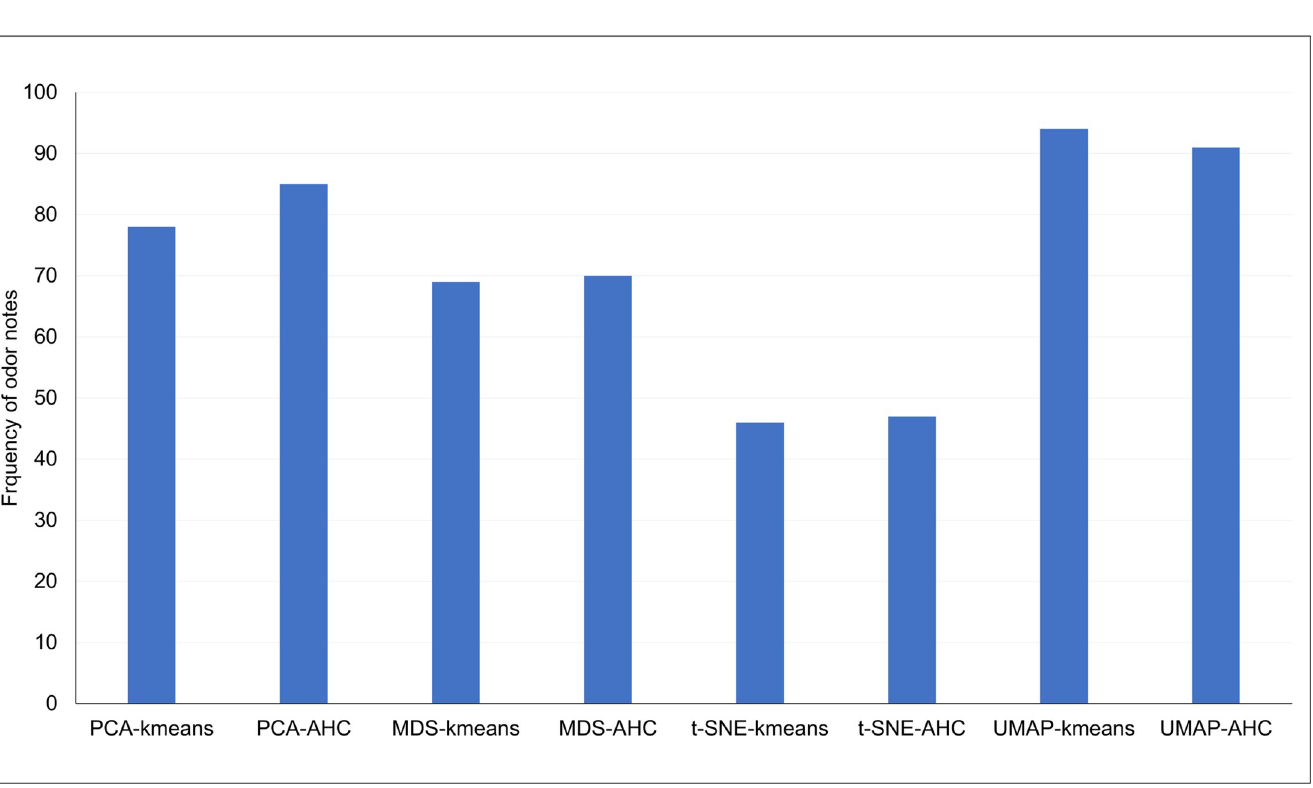
Fig 4. Radar charts of the distribution of the %ON values obtained for the 17 most frequent odor notes across the clusters. (a) Clusters obtained by PCA k-means method; (b) Clusters obtained by PCA-AHC method; (c) Clusters obtained by MDS k-means method; (d) Clusters obtained by MDS-AHC method; (e) Clusters obtained by t-SNE k-means method; (f) Clusters obtained by t-SNE-AHC method; (g) Clusters obtained by UMAP k-means method; (h) Clusters obtained by UMAP-AHC method. In each chart, C1, C2, C3, C4 and C5 clusters are depicted respectively in blue, in orange, in grey, in yellow, in light blue.